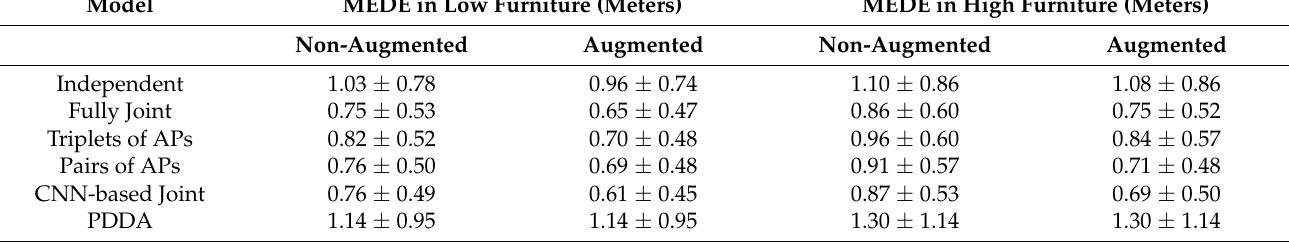
Table 1. MEDE ± standard deviation comparison of each model and PDDA when evaluated in 2123 spatially distributed locations that have not participated in model training of the low furniture and the high furniture